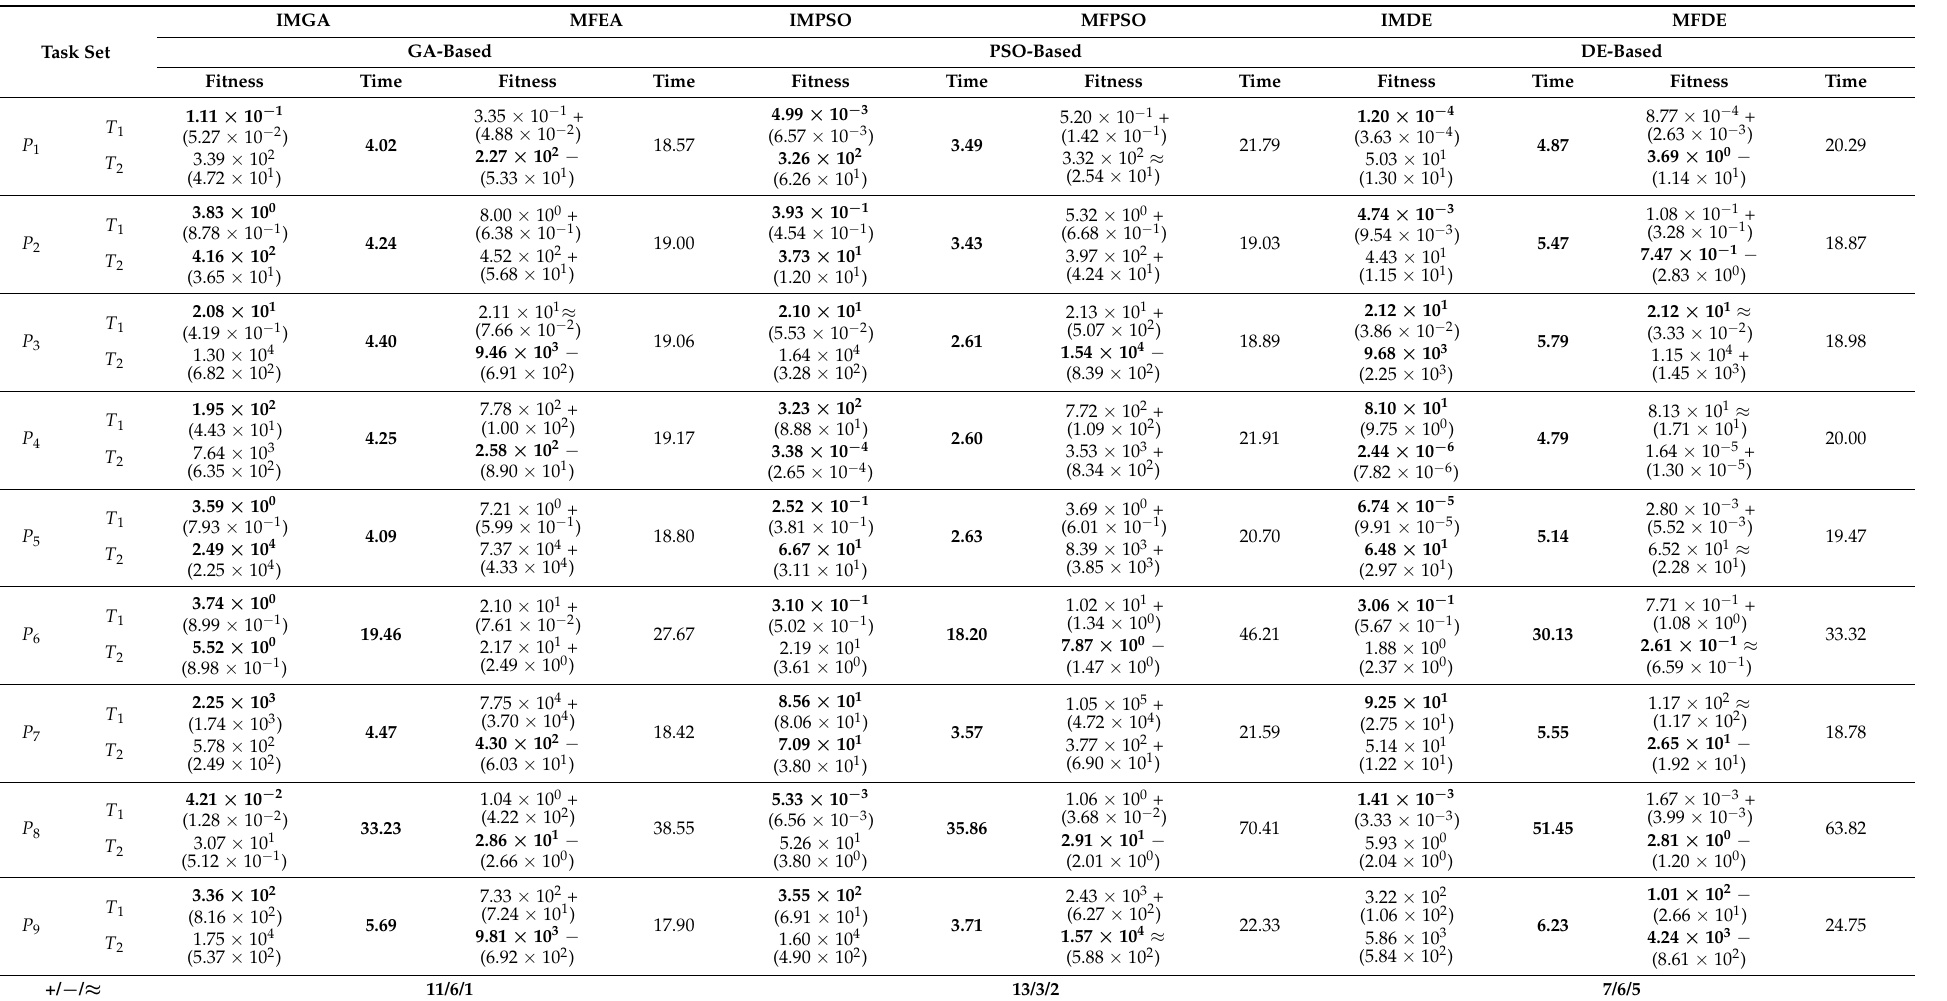
Table 4. Results of computational time(s) and the mean and standard deviation (in brackets) of the best fitness values in test suite